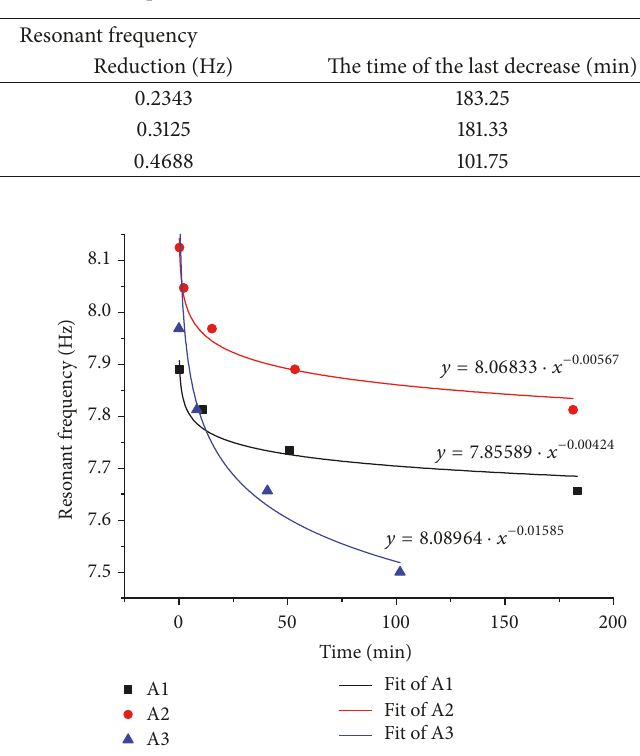
Table 5: The test results of Group A.